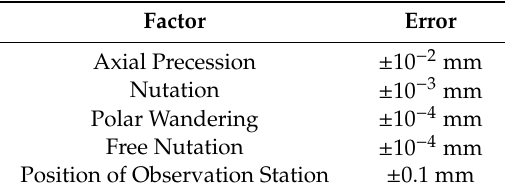
Table 1. Error of di ff erent influencing